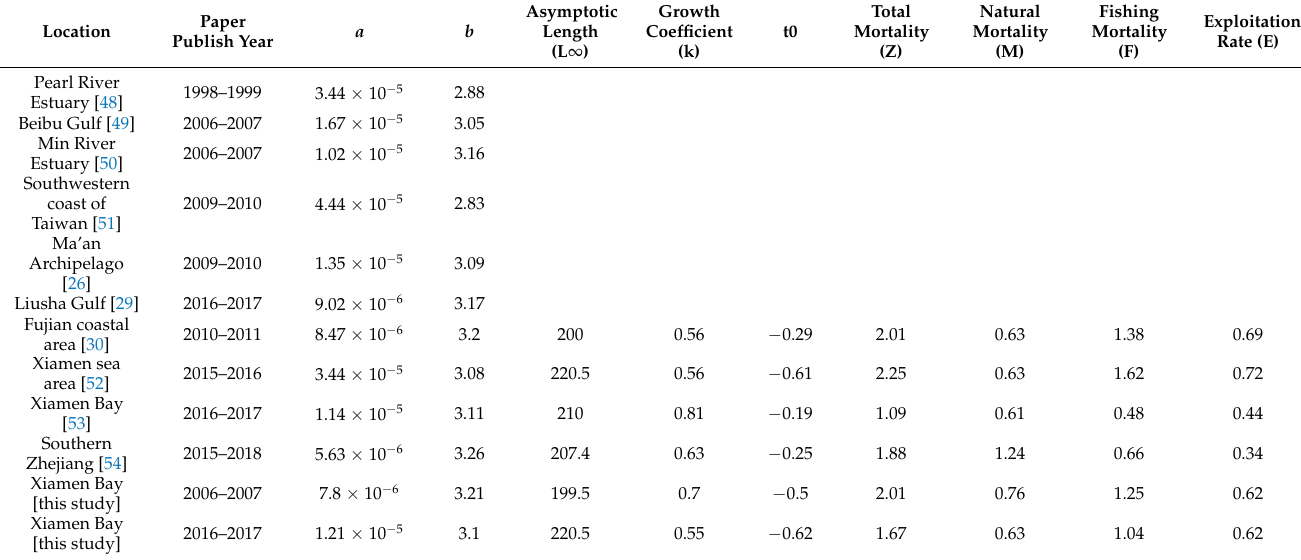
Table 4. Growth and mortality parameters of Johnius belengerii in different seas of